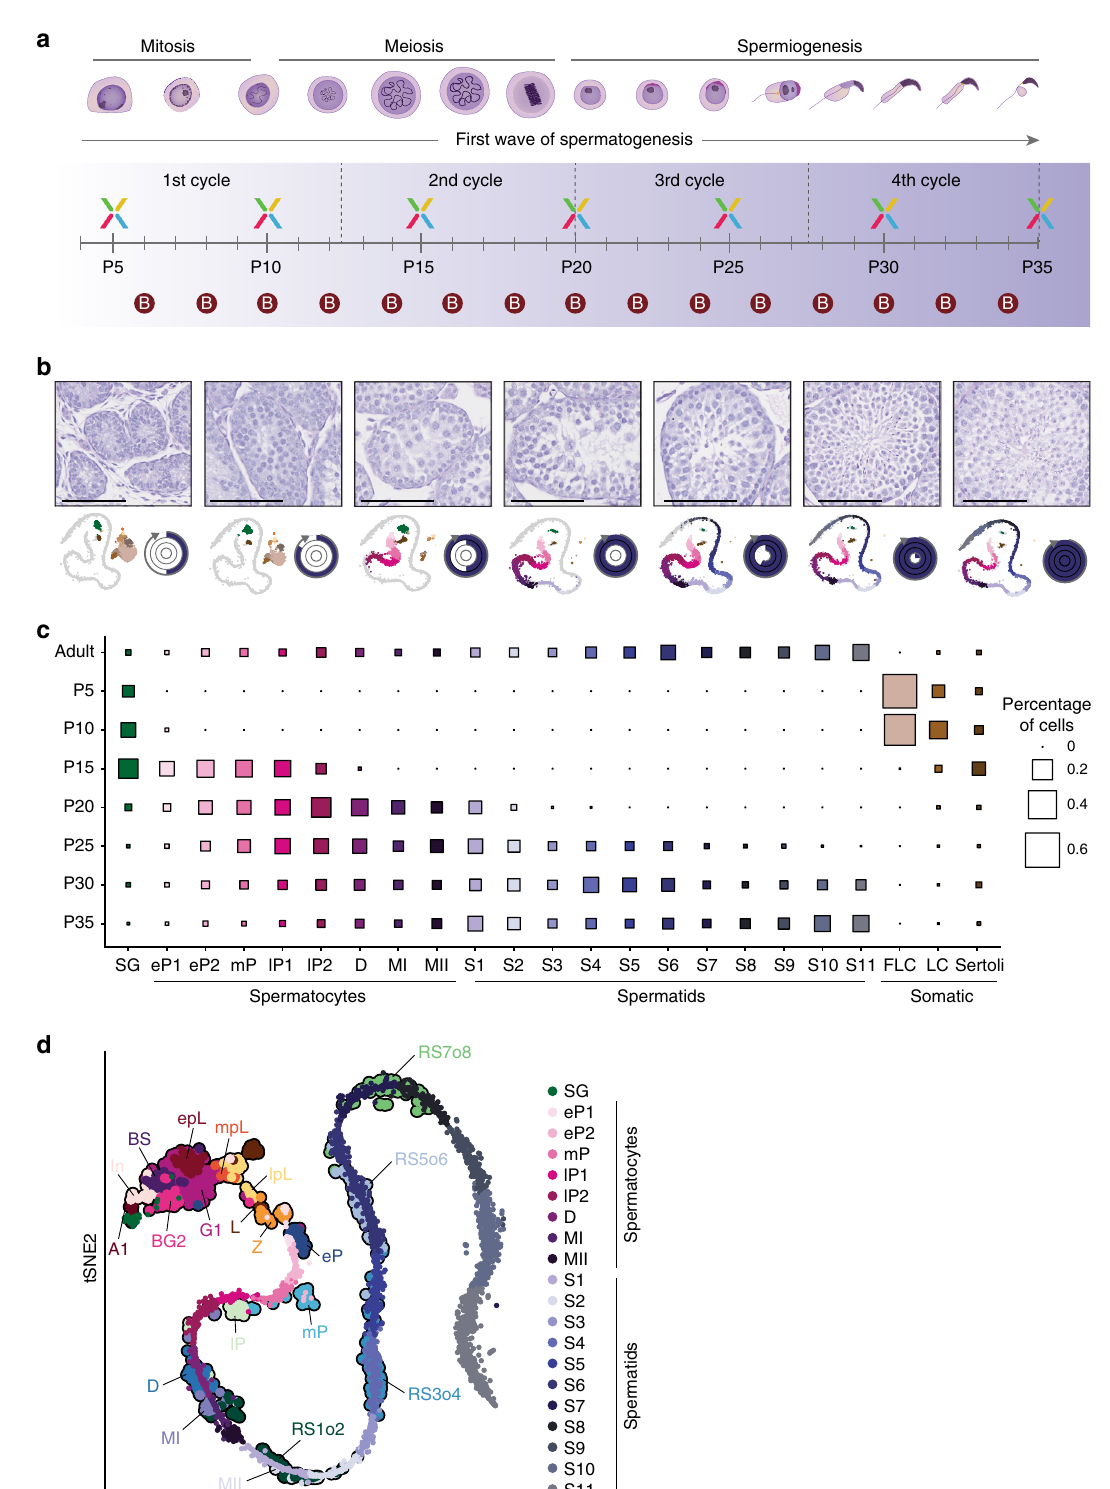
them along their differentiation time-course (Fig. 3a, c, Supplementary Fig. 5b, Methods). We detect two clusters (Undiff 1 and Undiff 2) corresponding to undifferentiated spermatogonia (A undiff ) based on expression of Zbtb16 and Sdc4 (Fig. 3b, c; Supplementary Data 6) 36 , including a small number of cells that express SSC markers, Gfra1 and Id4 35 (Supplementary Fig. 5c,